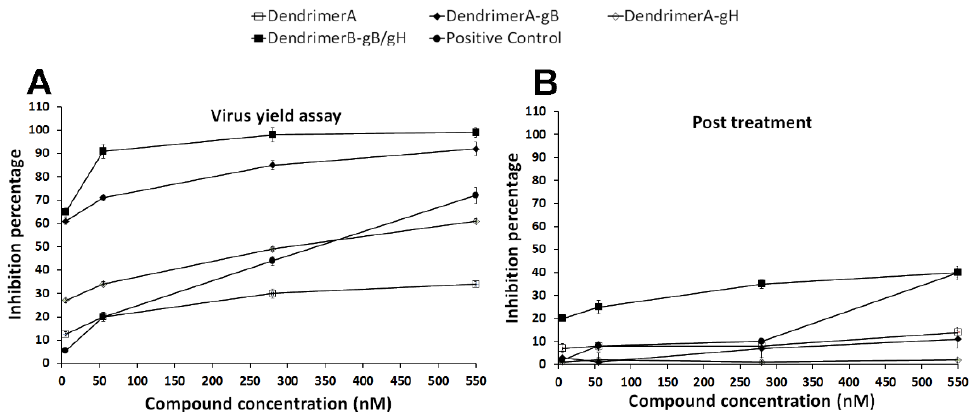
Figure 5. ( A ) Compounds were present in the cell culture during and after viral adsorption (virus yield assay); ( B ) cells were exposed to compounds after virus penetration (post treatment). The control used in both experiments is acyclovir. Experiments were performed in triplicate, and the percentages of inhibition were calculated with respect to no-compound control experiments. Error bars represent standard deviations.